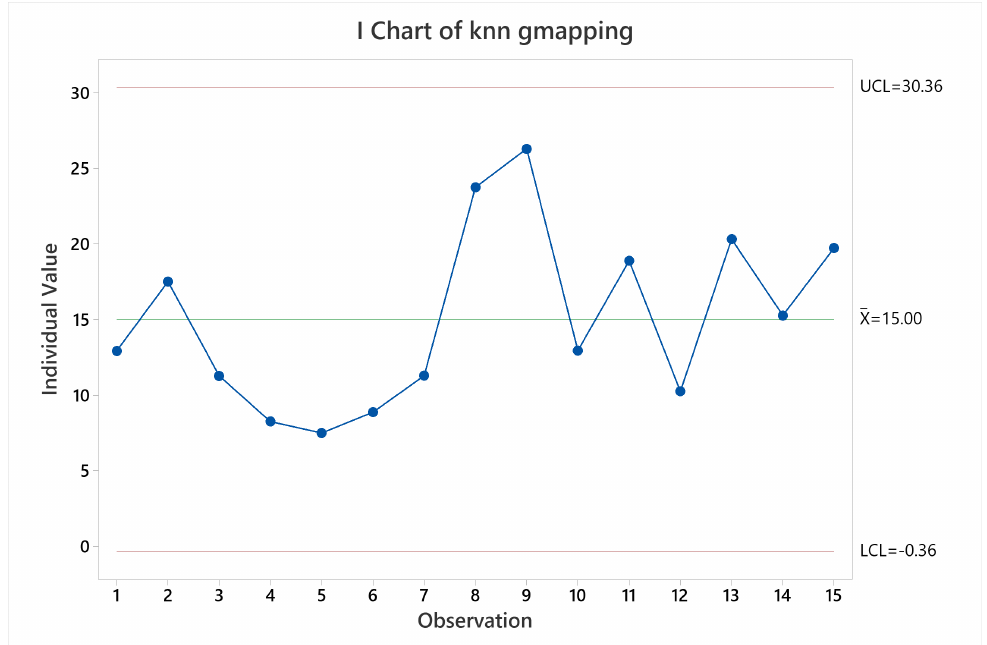
Figure 18. Map accuracy mean behavior for